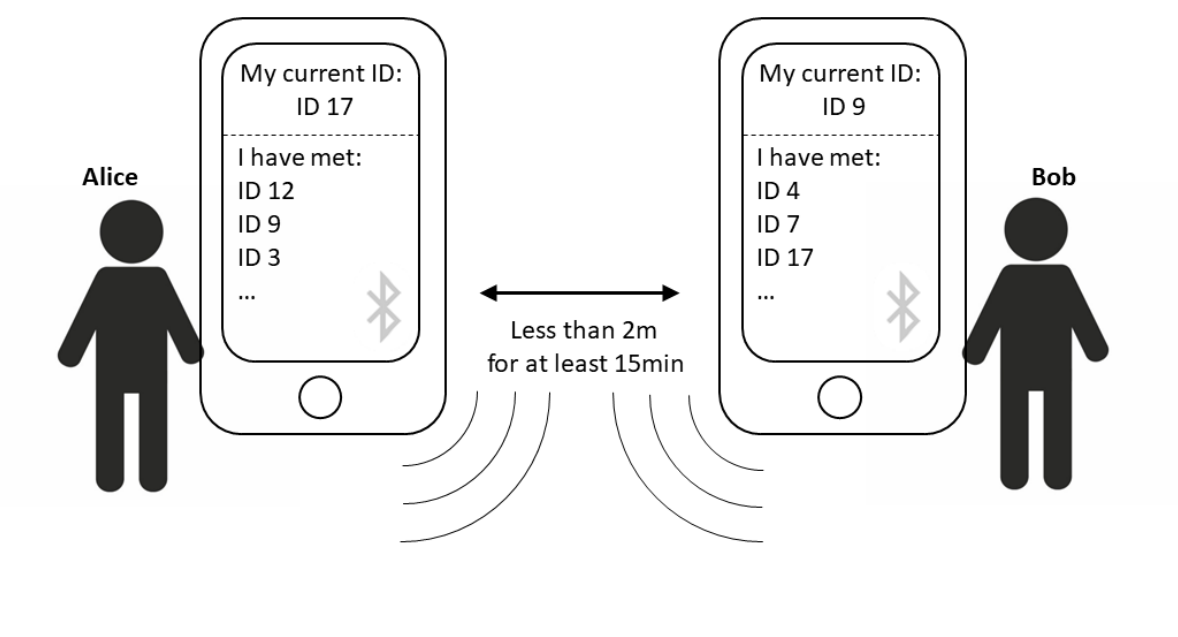
Figure 1. A COVID-19 tracing approach via Bluetooth. Every mobile phone stores a list of mobile phones that were within 2 m for at least 15 minutes. IDs are temporary but can be decrypted by the server.